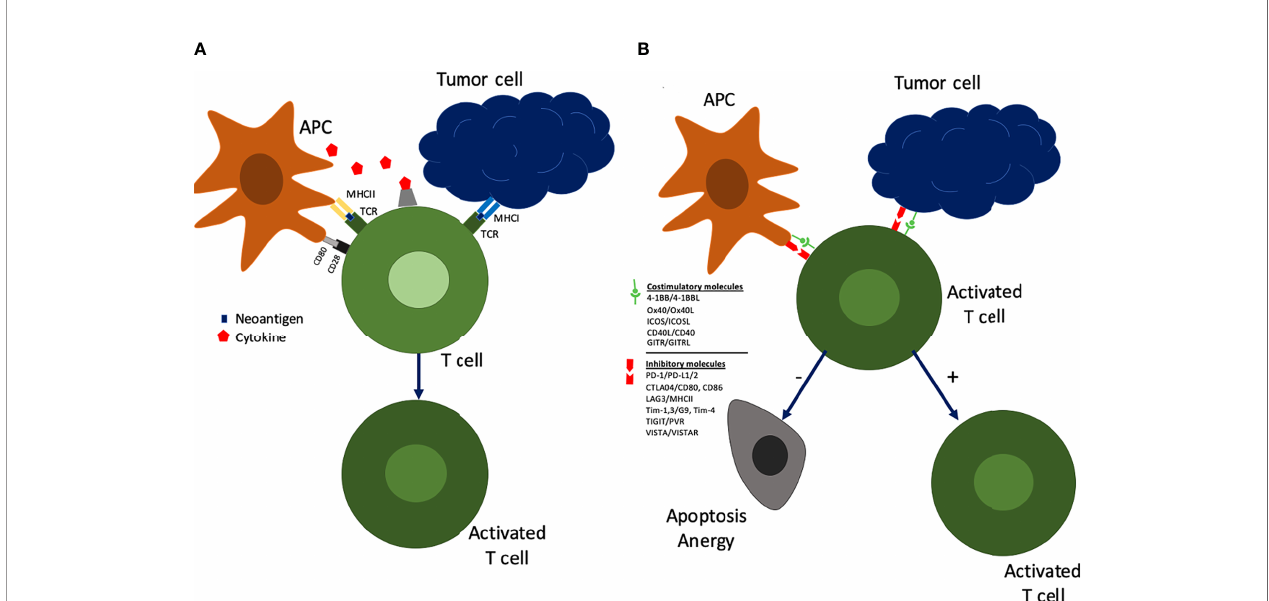
FIGURE 1 | Tumor cells and antigen presenting cells (APCs) interact with immature T cells in a series of signals leading to their activation and subsequent